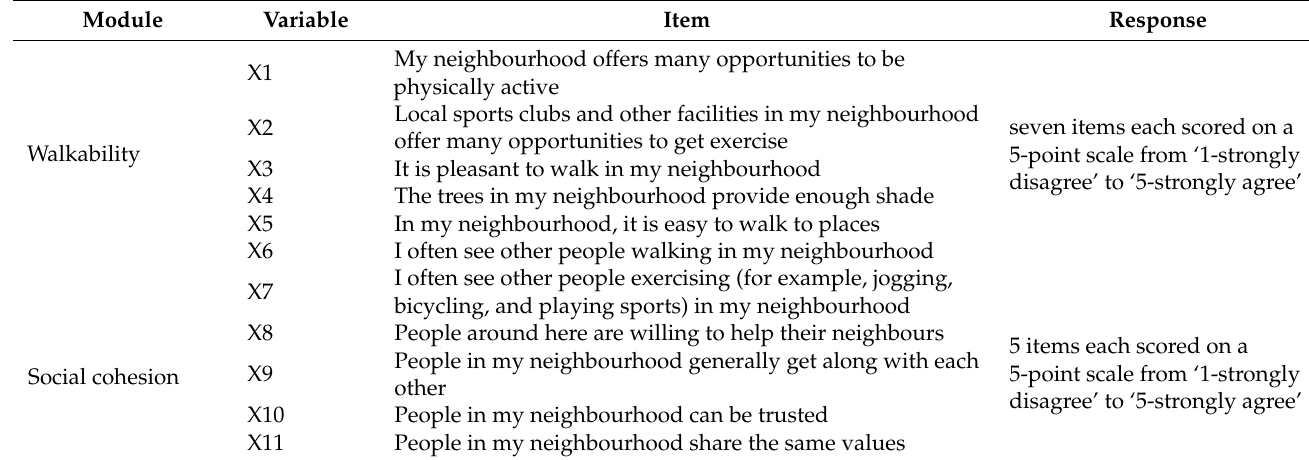
Table 1. Specific items for walkability and social